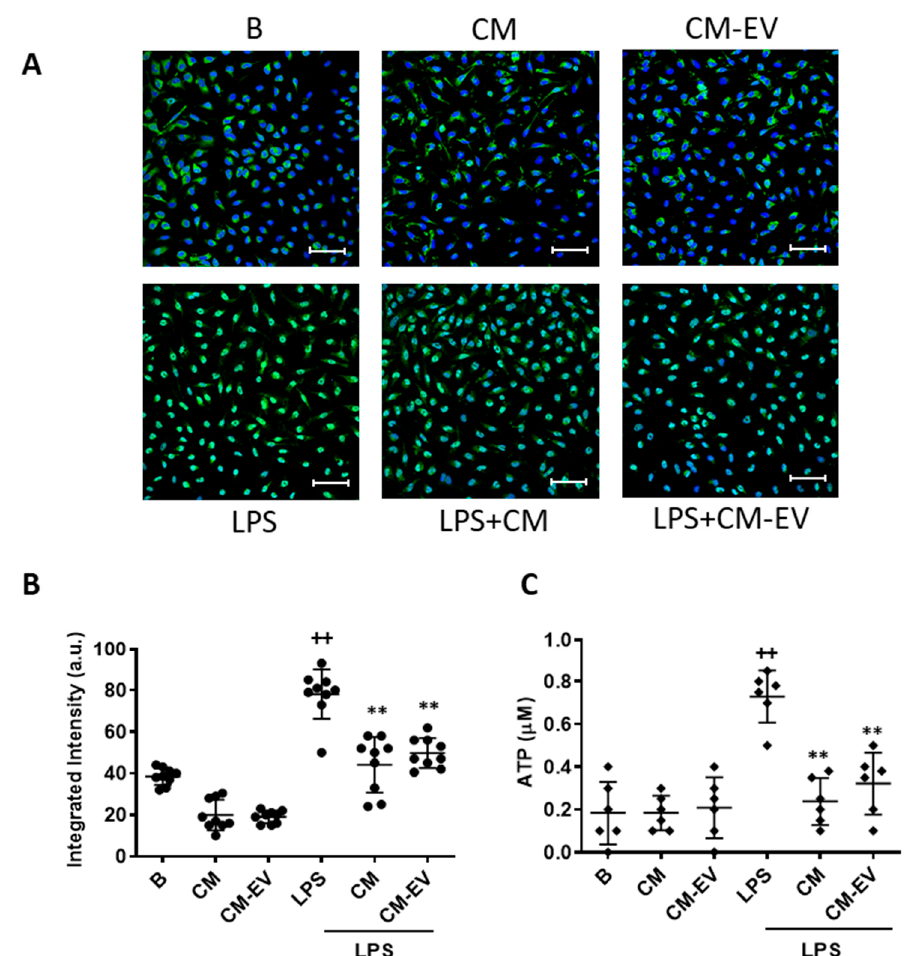
Figure 5. NF- κ B nuclear translocation and ATP release. For NF- κ B translocation, macrophages were incubated with CM or CM-EV for 30 min and immunofluorescence was determined by confocal microscopy using an NF- κ B p65 XP ® Rabbit (Alexa Fluor ® 488 Conjugate). ( A ) Representative images. Microscopic magnification of the objective lens 40 x. Bar = 50 µ m. ( B ) Quantification of nuclear translocation. For ATP release ( C ), macrophages were incubated with CM or CM-EV in the presence or absence of LPS for 20 h. ATP levels were determined by luminescence in the medium. B: cells incubated with control medium and not stimulated with LPS. Data are presented as mean ± SD ( n = 6–9) from 3 independent experiments. One-way analysis of variance followed by Tukey’s post hoc test; ++ p < 0.001 versus B; ** p < 0.01 versus LPS control.